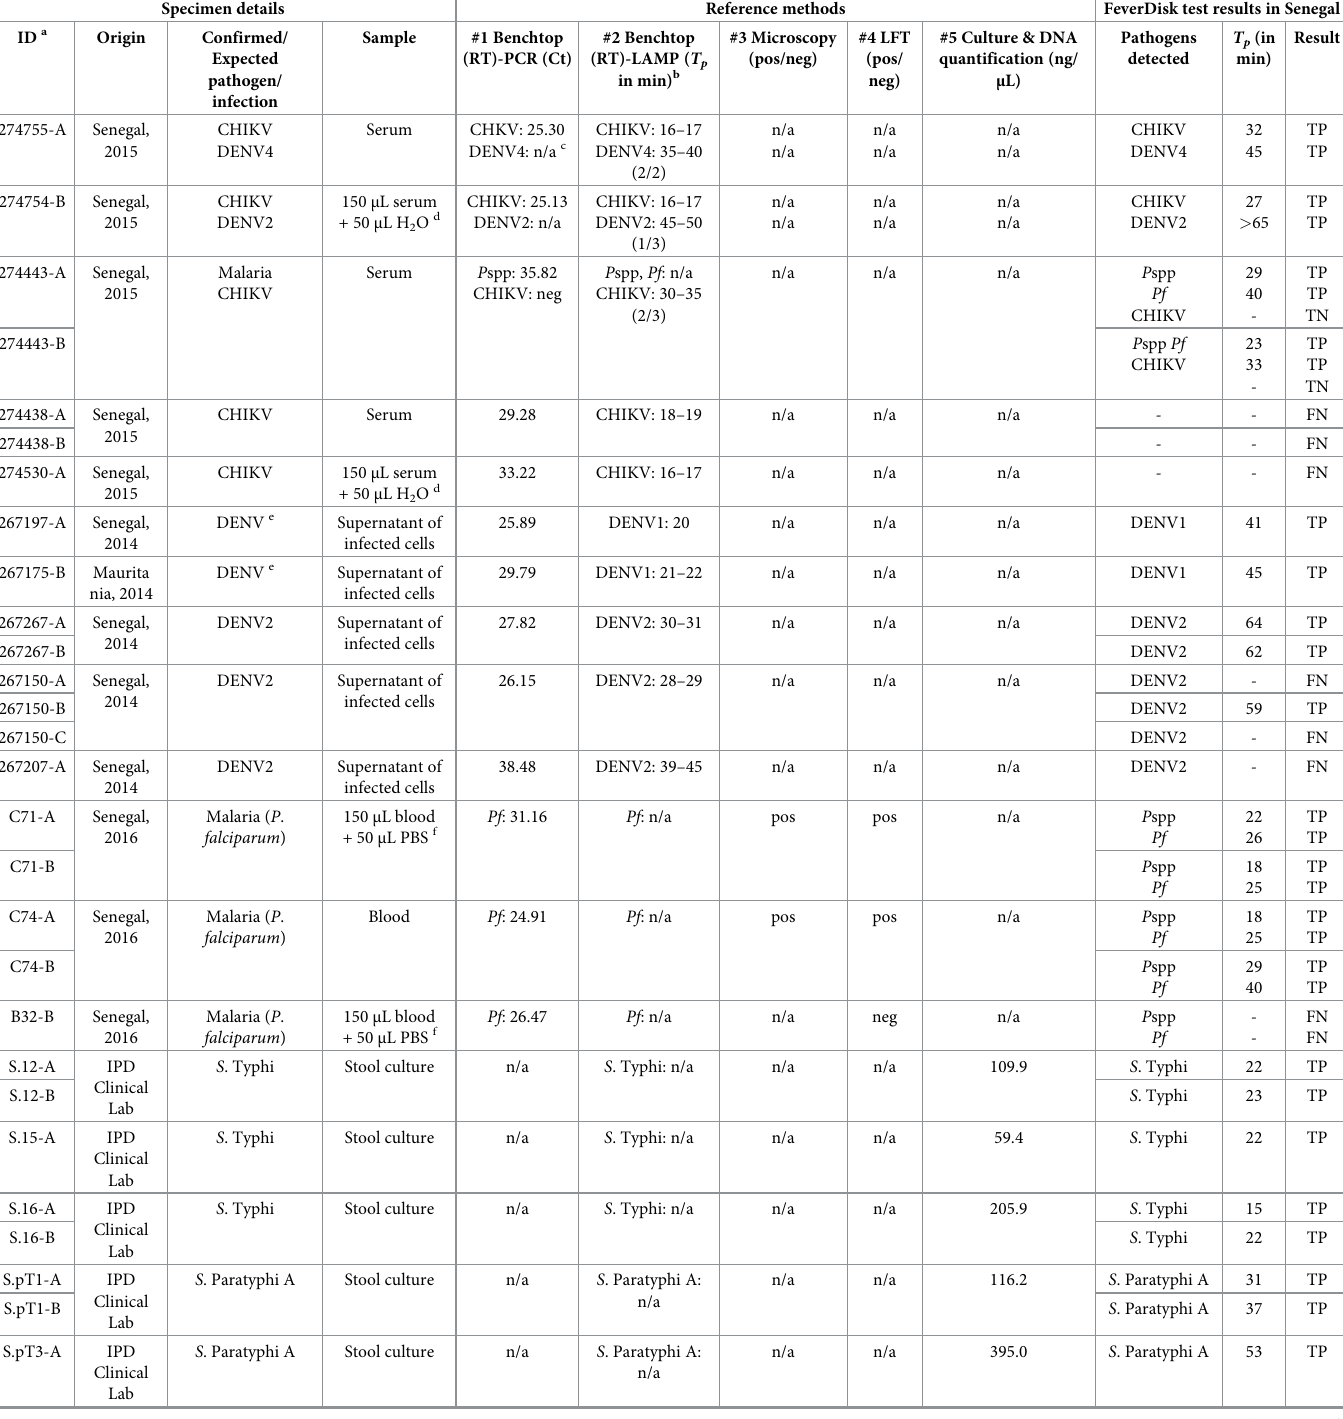
Table 1. Overview of results from the test series in Senegal where 29 FeverDisks were used. The reference methods as well as the FeverDisk results are